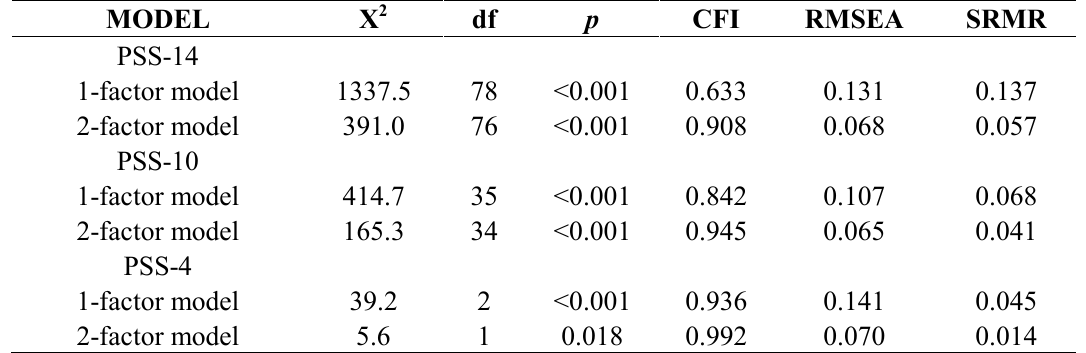
Table 1. Results of confirmatory factor analyses of model testing of PSS-14, PSS-10 and